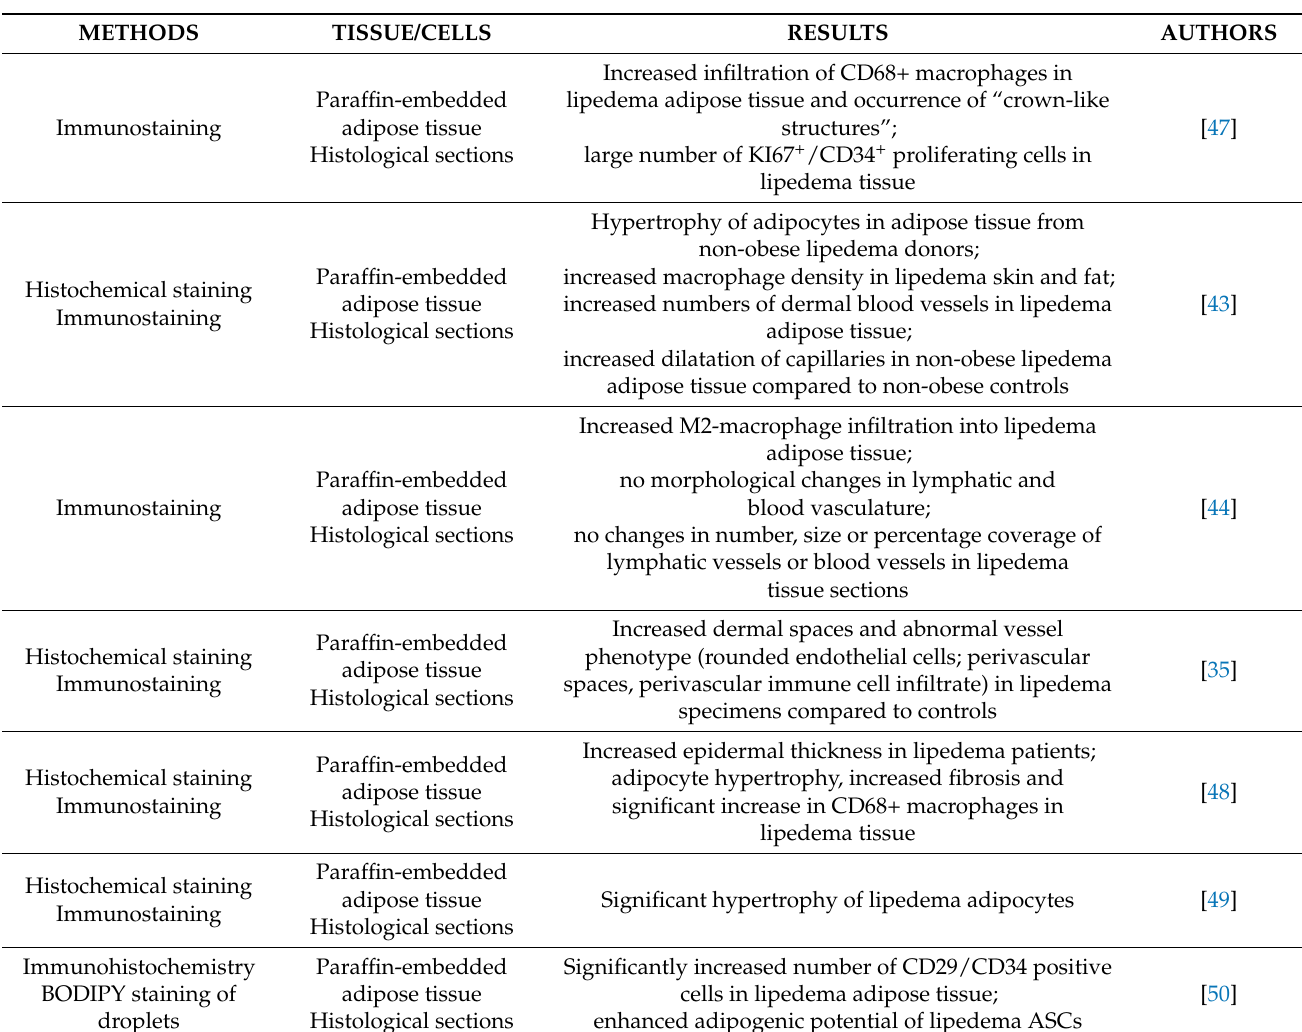
Table 1. Histological/morphological, histochemical and immunocytochemical